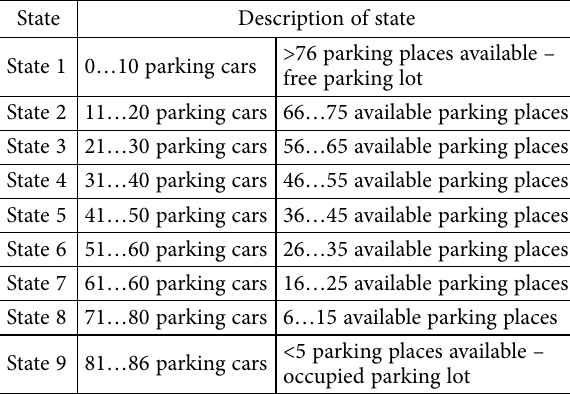
Table 1. State definition of parking